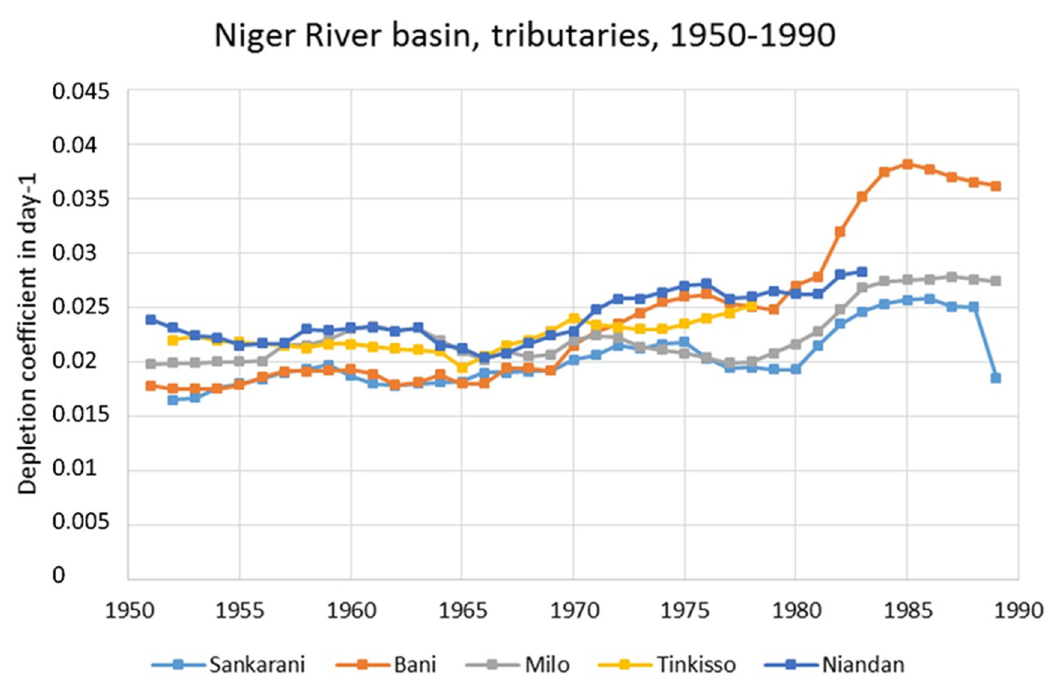
Figure 14. Evolution of DC in some Sudano-Guinean tributaries of the Niger River before and during the drought [41].